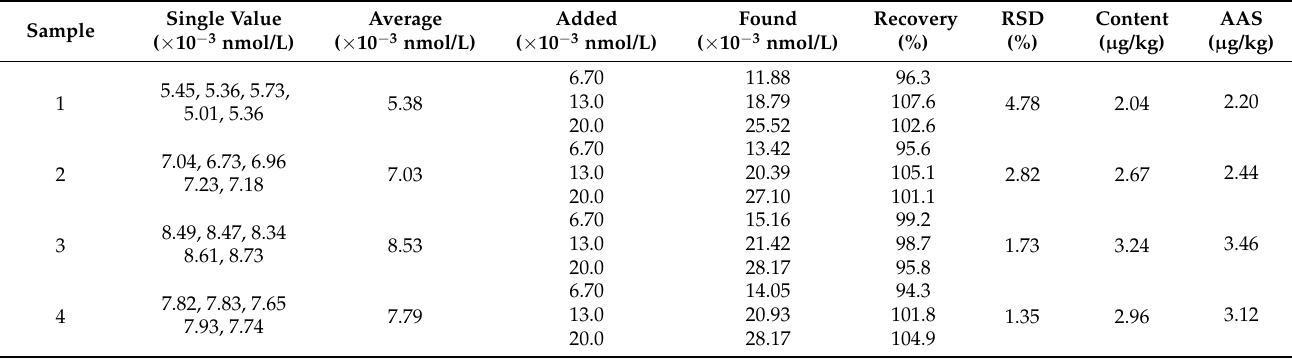
Table A5. The results of OTC sample